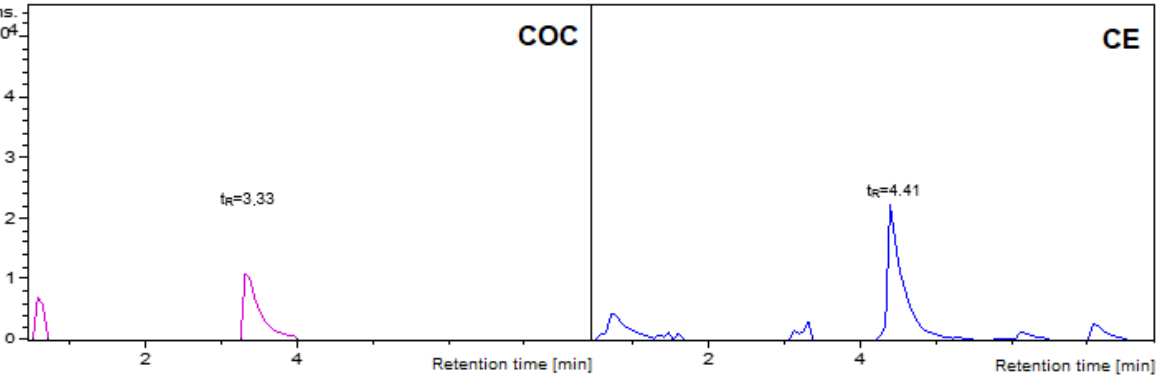
Figure 4. Chromatogram confirming the detection of cocaine (COC) and cocaethylene (CE) in the postmortem case sample tested.